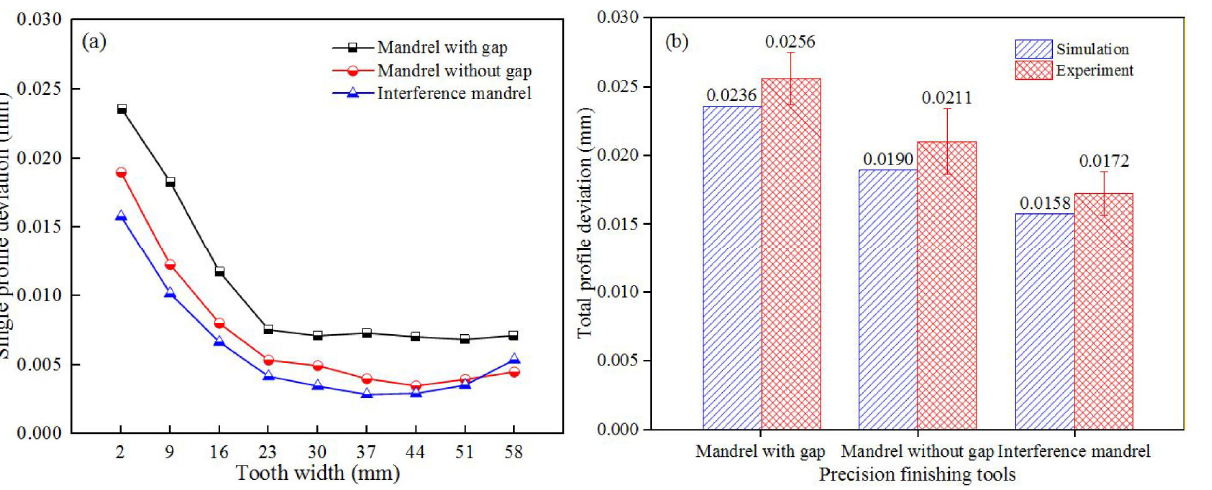
Figure 9. Profile deviations of external gear at different finishing tools: ( a ) Single and ( b )